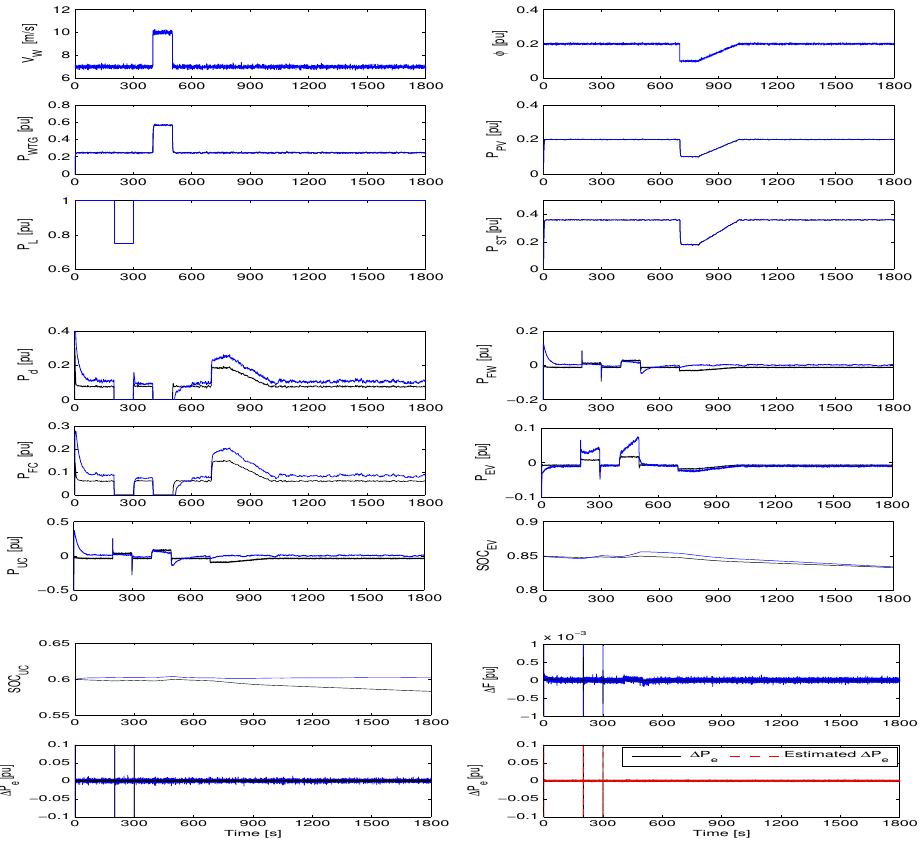
Figure 15. Case 1 simulation results: PF (black), FLC